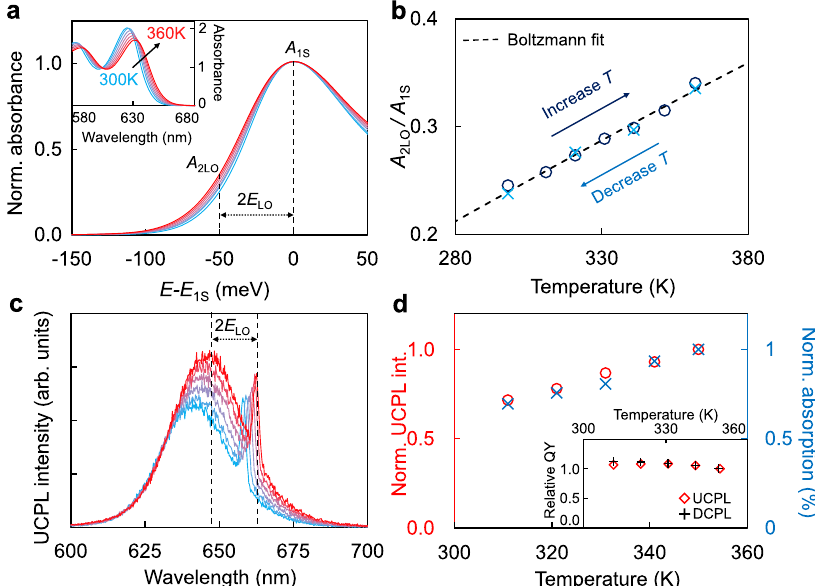
Fig. 2 Temperature-dependent absorption and photoluminescence spectra of QDs. a The fi rst-excitonic absorption (1S) peak overlapped absorption spectra at different temperatures. The x-axis denotes the photon energy ( E ) relative to the energy of the 1S peak ( E 1S ) for each spectrum. E LO is the energy of the longitudinal optical phonon of CdSe. A 1S and A 2LO are the absorbances at E 1S and E 1S − 2 E LO respectively. Inset: Original absorption spectra. b Temperature-dependent ratio of A 2LO and A 1S in both increasing (deep blue circle) and decreasing (light blue cross) temperature ( T ) processes. The black dashed line represents a fi tting to the Boltzmann distribution function. c UCPL spectra at different temperatures with excitation photon energy being 2 E LO lower than the average photoluminescence photon energy. The corresponding normalized temperature-dependent UCPL intensity (red circle) and the percentage absorption at the excitation wavelength (blue cross) are plotted in ( d ). Inset: temperature dependence of relative quantum yields (QY) for UCPL and